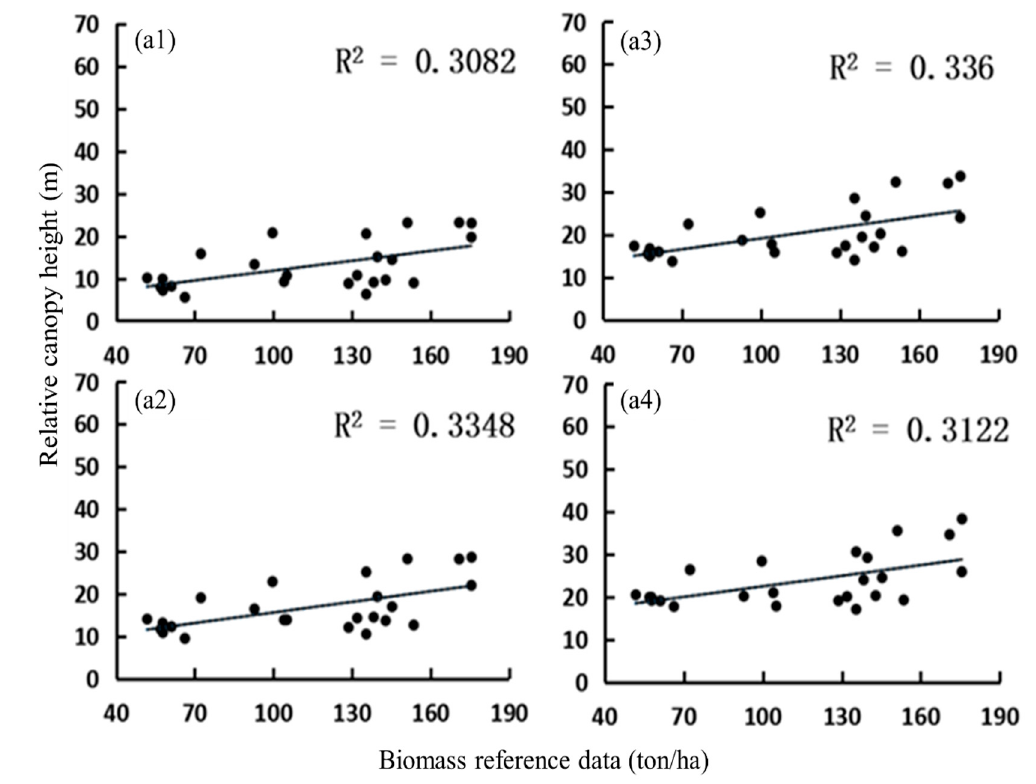
Figure 3. A comparison of the relationships between aboveground biomass and relative canopy height on the basis of different window sizes ( a1–a4 : window sizes of 5 × 5, 7 × 7, 9 × 9, and 11 × 11 pixels, respectively).